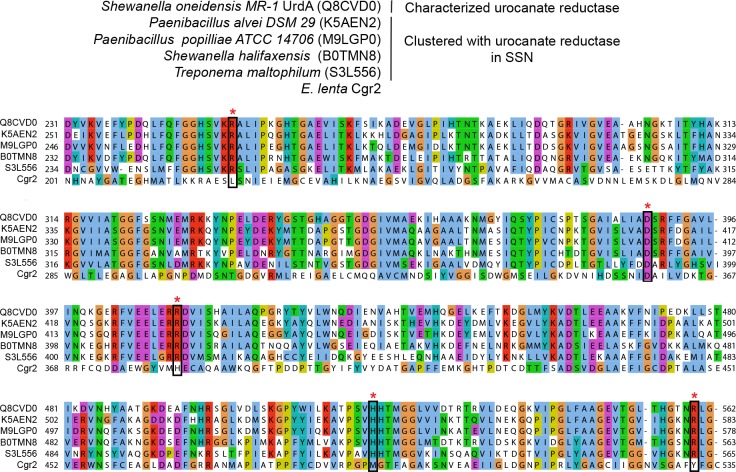
Multiple sequence alignment of urocanate reductases.UniProtKB ID numbers are shown in parentheses. Active site residues (marked with an asterisk) were conserved in characterized urocanate reductases and clustered proteins from the sequence similarity network and were not conserved in Cgr2.